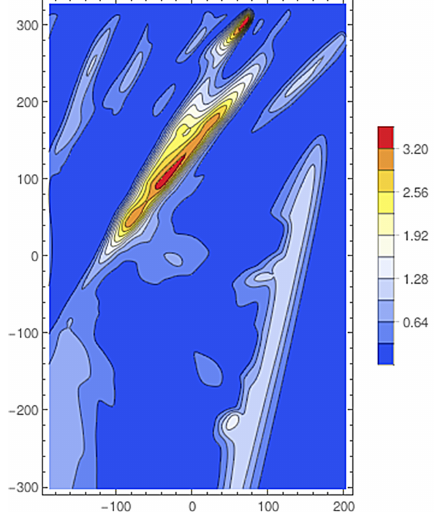
Figure 4. Typical contour plot of the log likelihood when Q = 0 with x , y positions as in Fig. 1. The values range from 0 to 3.55. χ -square distribution with 3 degrees Since the 95th percentile of a 1 2 of freedom is about 3.9, Q = 0 is contained in the 95% credible region for the parameters. Thus, the data are consistent with the hypothesis of no leak.